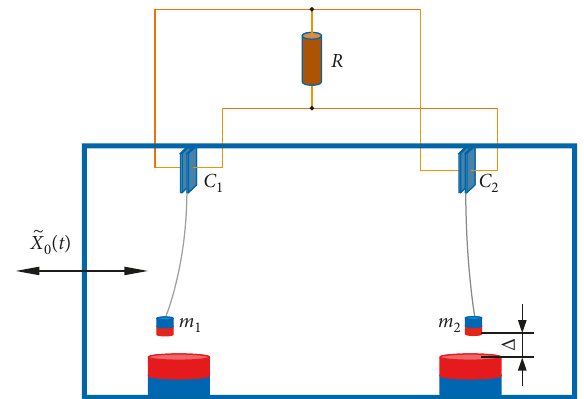
Figure 1: Schematic of the device in the current